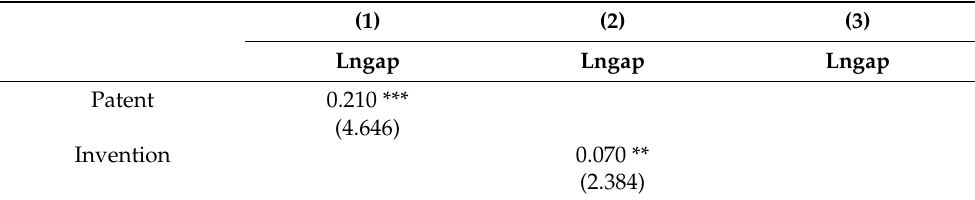
Table 6. Technology Innovation and Agricultural Economic